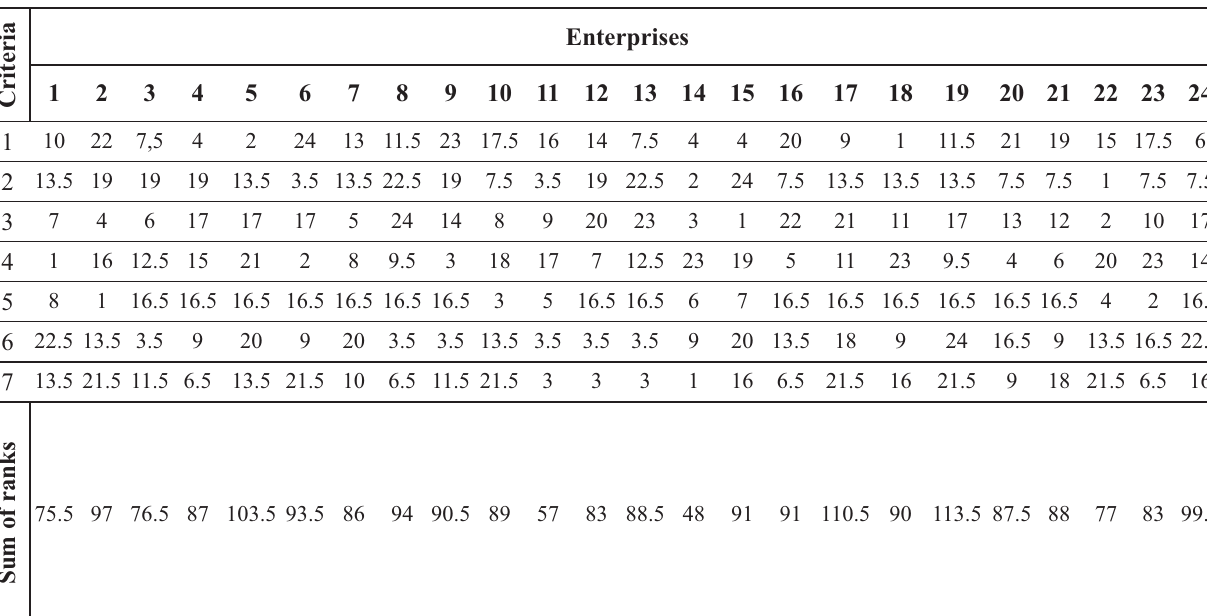
Table 6 . Ranks of enterprises based on criteria of Group 1